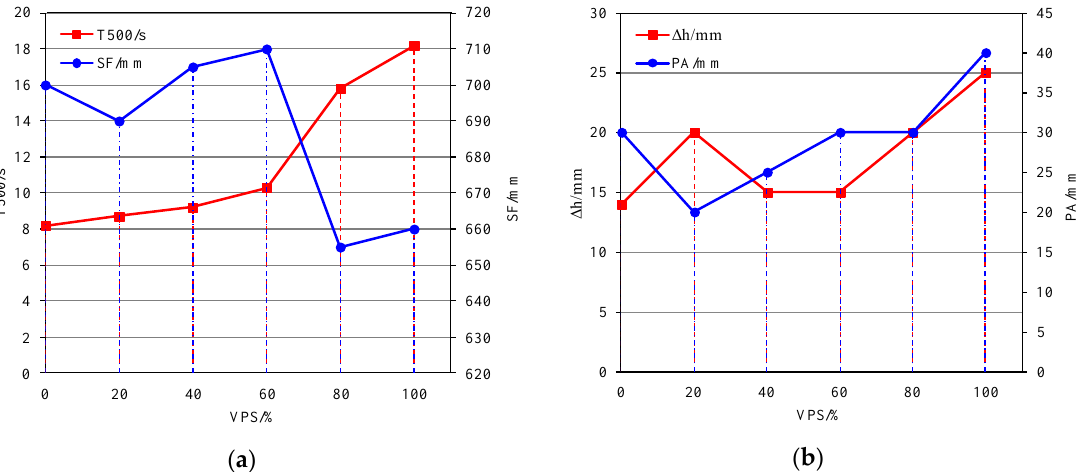
( b ) Figure 3. The basic workability test of S 0 SCC. ( a ) Slump flow test (SF = 700 mm); ( b ) J-ring test (SF J = 670 mm). According to observation in the experimental process and the test result listed in Table 12, the basic workability of S 0 SCC concrete can be obtained and shown as follows: (1) the SF result is 700 mm of fresh SCC and belongs to SF2 Grade according to JGJ/T 283-2012 [33], indicating that the fluidity of SCC mixture is ideal; (2) the T500 result is 8.2 s, within the range of 3 – 25 s, meeting the requirements; (3) the Δh result is 14 mm of fresh SCC, within the range of 0 – 25 mm, meeting the requirements; (4) the PA result is 30 mm, qualified as Grade PA1. There is no bleeding and